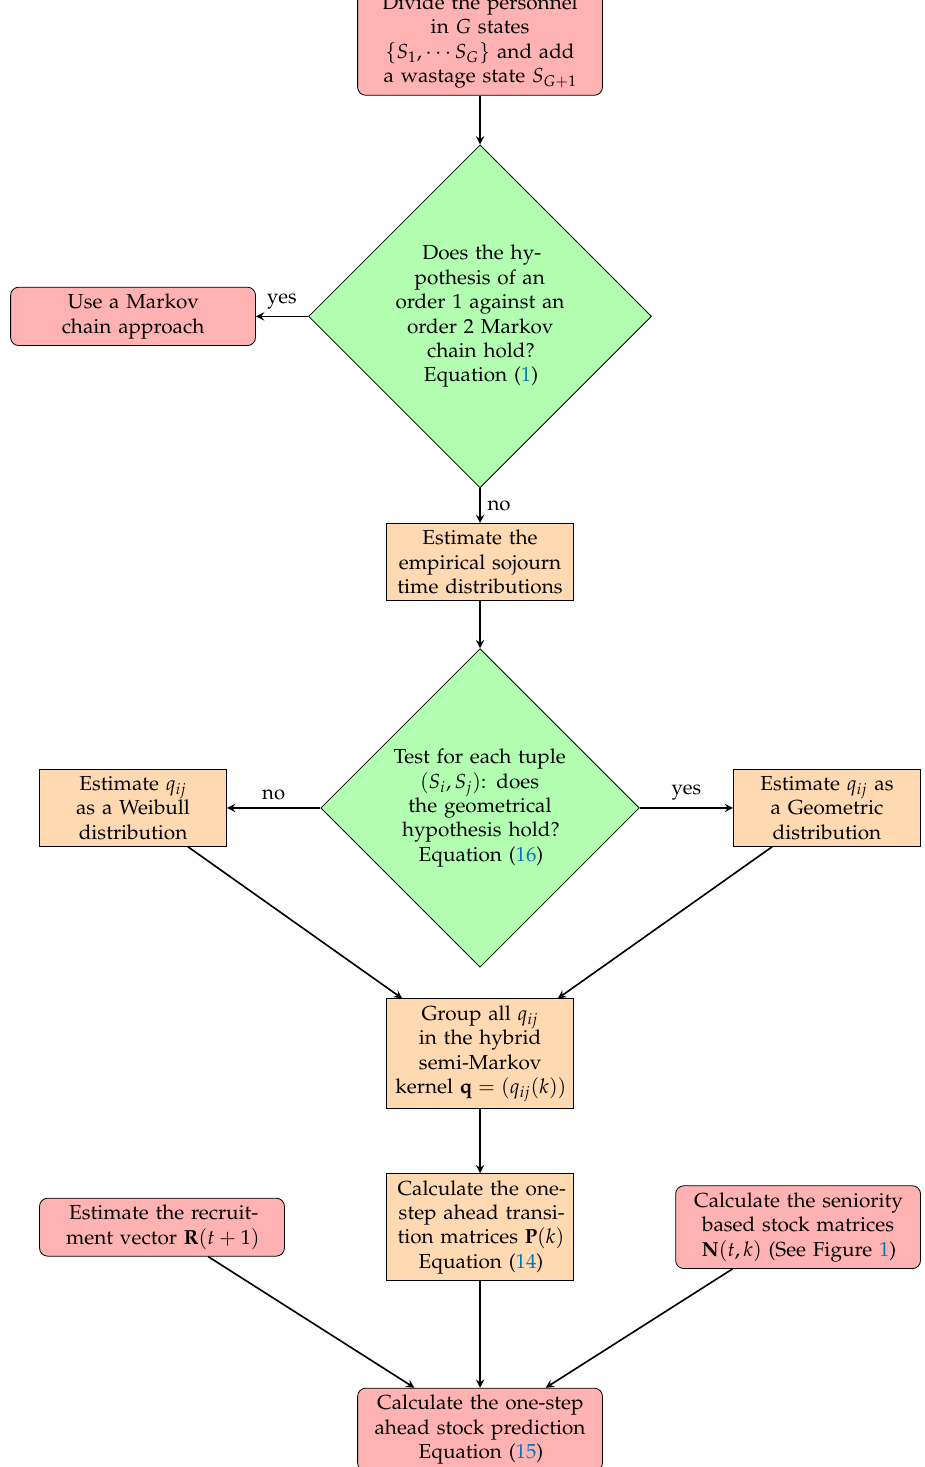
Figure 2. Decision flowchart for the hybrid semi-Markov